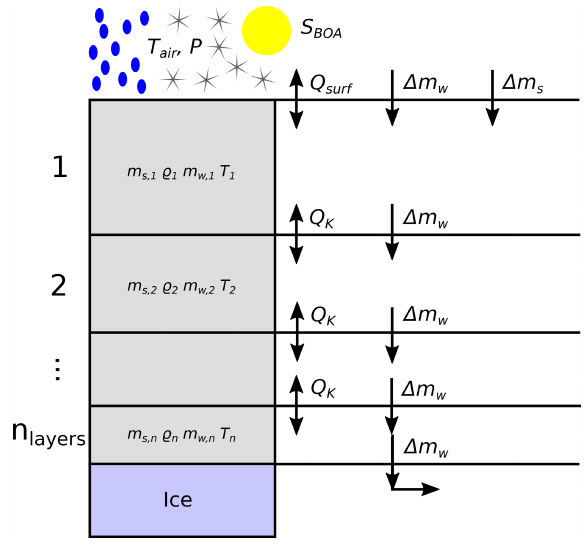
Figure 3. Set-up of snow layers with fluxes of energy and mass and snow quantities in one snow column. Table 3. Measurements of annual average firn temperatures at a depth of 10m (see map in Fig.